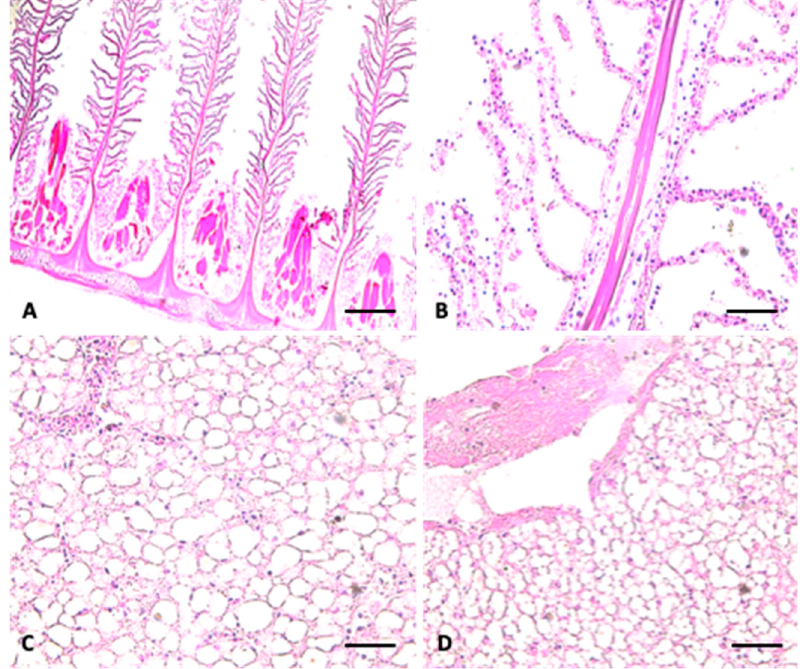
Figure 4. Sections stained with Hematoxylin-Eosin. ( A , B ); gills sections ( C , D ); male liver sections, is evident a di ff use steatosis. Scale bar A,C and D: 200 µ m; B 100 µ